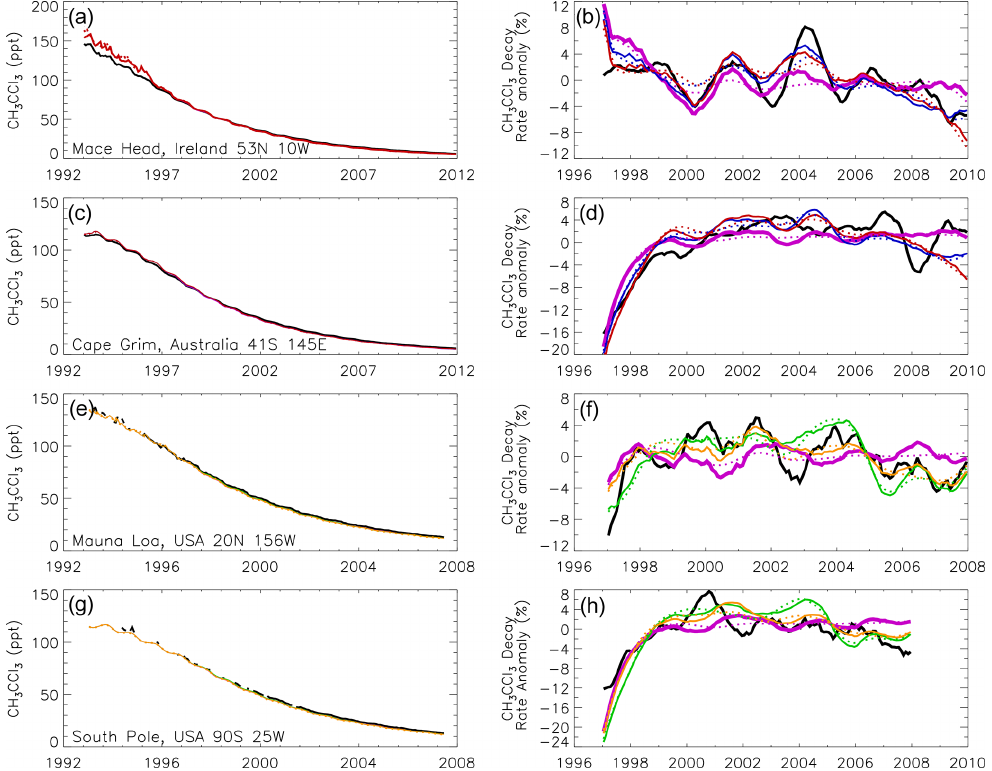
Figure 3. (Left) Observed mean surface CH 3 CCl 3 (ppt) (black line) from (a) Mace Head (AGAGE), (c) Cape Grim (AGAGE), (e) Mauna Loa (NOAA), and (g) South Pole (NOAA). Also shown are results from five TOMCAT simulations with fixed temperatures and varying winds (FTVW; for legend see Fig. 2a). (Right) Surface CH 3 CCl 3 decay rate anomalies at the same station as the corresponding left column plot for observations (black), TOMCAT simulations with varying winds (FTVW, solid coloured lines), and TOMCAT simulations with fixed winds (FTFW, dotted lines). Comparisons at NOAA (AGAGE) stations show only comparisons with runs using NOAA (AGAGE)-derived OH, along with runs RE_FTVW and RE_FTFW in all panels. Table 3. Calculated methane changes over different time periods from selected TOMCAT experiments and the NOAA and AGAGE